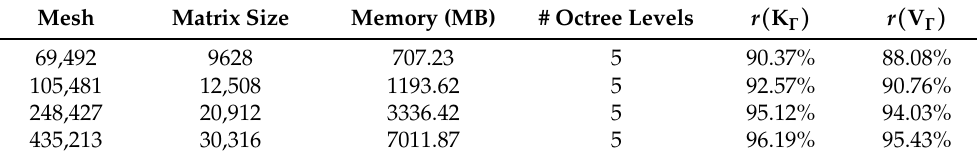
Table 10. Compression ratio of single-layer matrix K Γ and double-layer matrix V Γ with R-SVD.